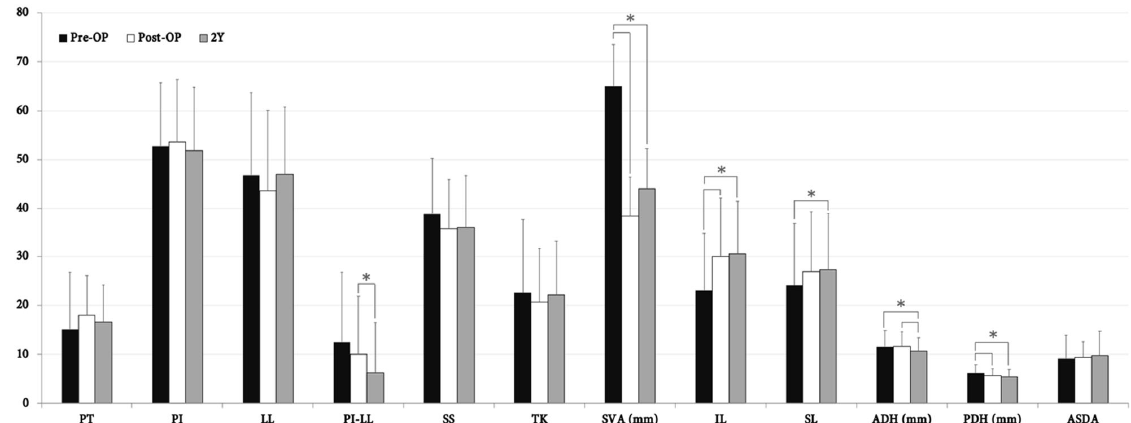
Figure 3. Radiographic outcome measured at pre ‐ OP, post ‐ OP, and 2 ‐ year follow ‐ up amongst all patients ( n = 50). *, statistically significant between measurements ( p < 0.05). PT, pelvic tilt; PI, pelvic incidence; LL, lumbar lordosis; PI ‐ LL, PI minus LL; SS, sacral slope; TK, thoracic kyphosis; SVA, sagittal vertical axis; IL, index lordosis; SL, segmental lordosis; ADH, anterior disc height; PDH, posterior disc height; ASDA, adjacent segment disc angle; Y, year.